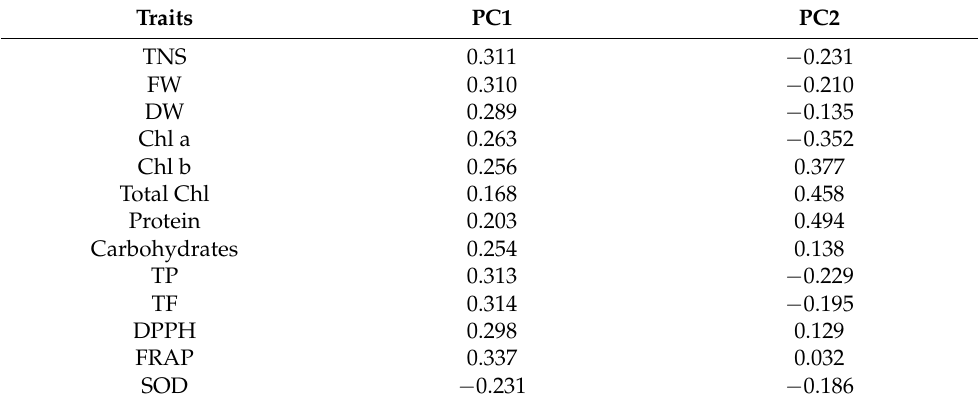
Figure 5. Principal component analysis of physio-biochemical indices of P. tuberosa shoots for different elicitor treatments. Table 2. Loading matrix for principal